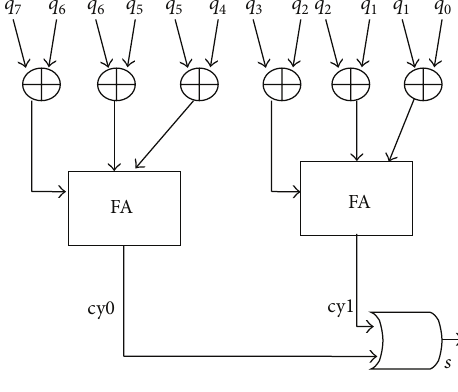
Figure 4: Switching transition counter.